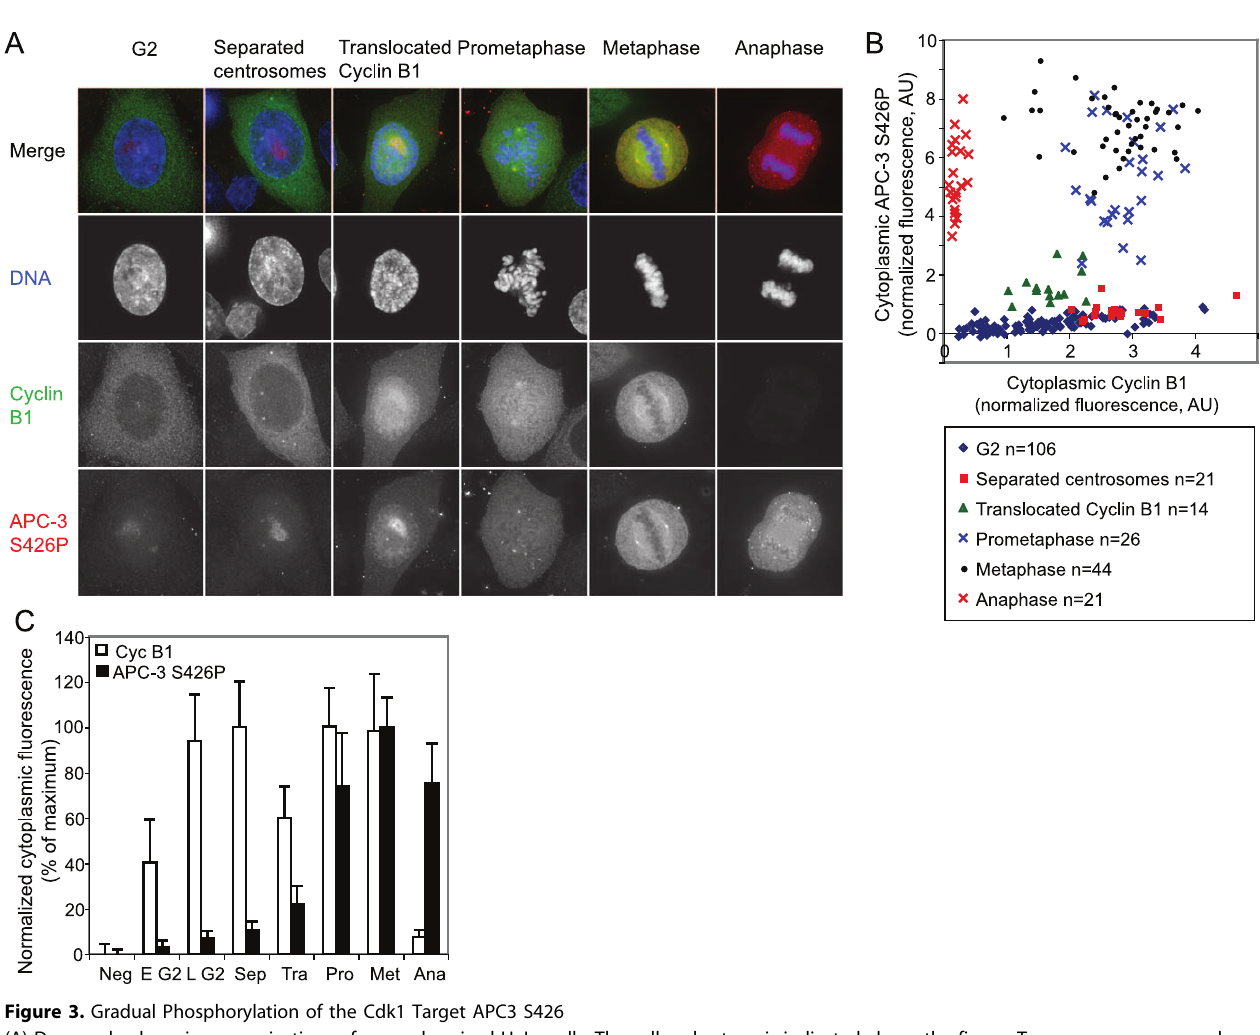
Figure 3. Gradual Phosphorylation of the Cdk1 Target APC3 S426 (A) Deconvolved maximum projections of unsynchronized HeLa cells. The cell-cycle stage is indicated above the figure. Top row: merge, second row: DNA, third row: cyclin B1, bottom row, APC3 S426P. (B) Dot plot of cytoplasmic cyclin B1 and cytoplasmic APC3 S426P staining. Each dot corresponds to one cell. Cells are arranged according to morphology and staining as in Figure 2A. (C) Average values of cytoplasmic cyclin B1 and phosphorylated APC3. Values are shown as percentage of the highest average. Error bars indicate SD. Bars are labeled as in Figure